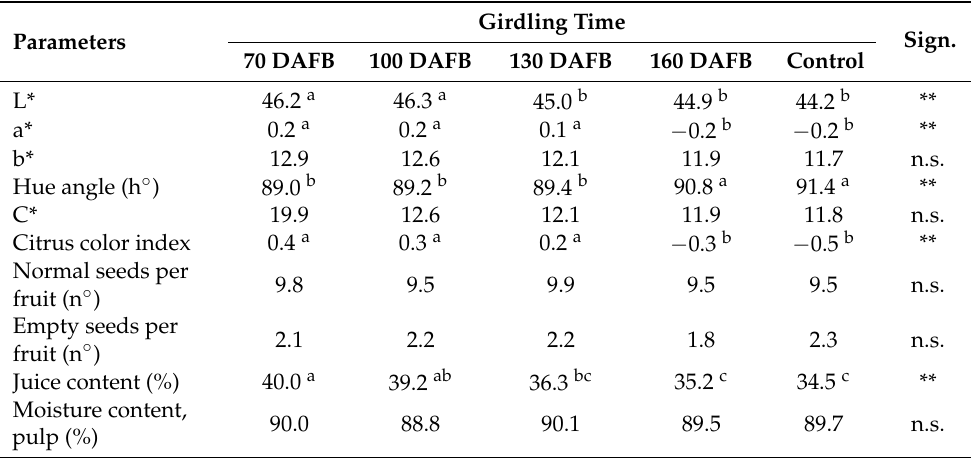
Table 3. Effects of girdling time on the main pulp characteristics.